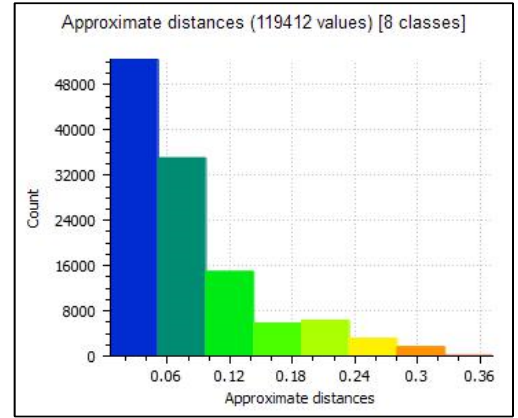
Figure 9: Discrepancy map between the TLS cloud and UAV Photoscan processing.